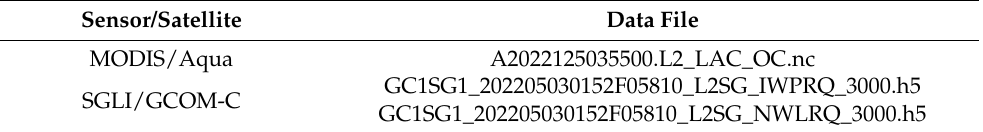
Table 1. List of the files used in the data ingestion demo case. The Python code with the procedure discussed in this study is available from the link https://github.com/npec/ee-oc-data-ingestion. Sensor/Satellite Data File